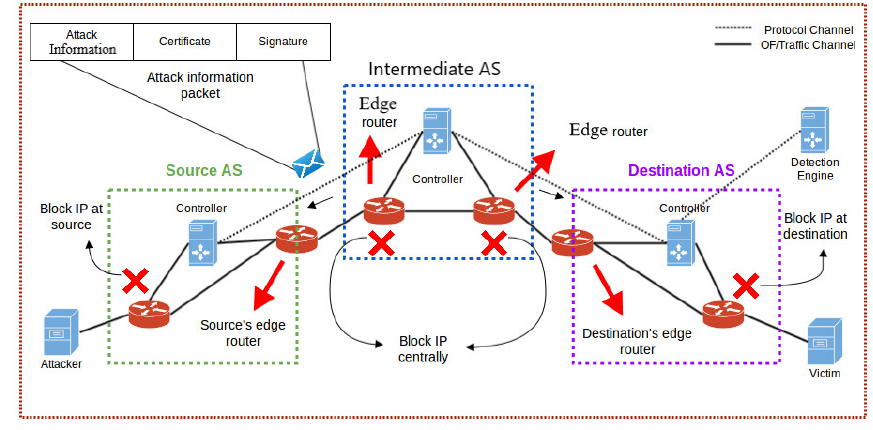
Figure 1. High-level Architecture of Collaborative DDoS